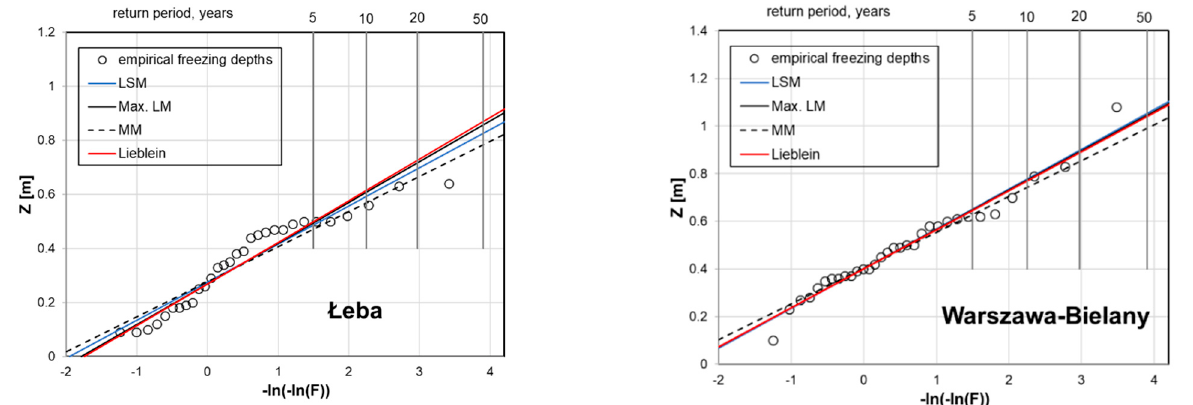
Figure 6. Estimation models for results from Łeba ( left ) and Warszawa-Bielany ( right ) station—predicted position of zero isotherm for return period.